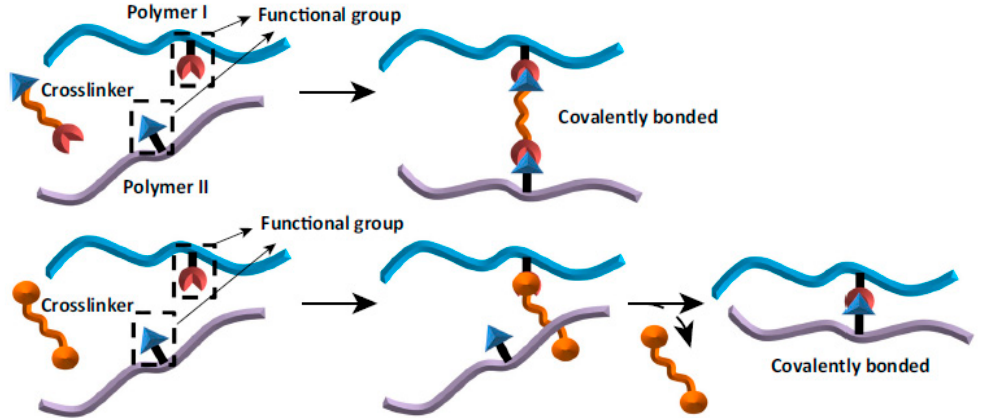
Figure 1. The scheme of chemical cross-linking. Reprinted (with some modifications) from [1] with permission of Elsevier.